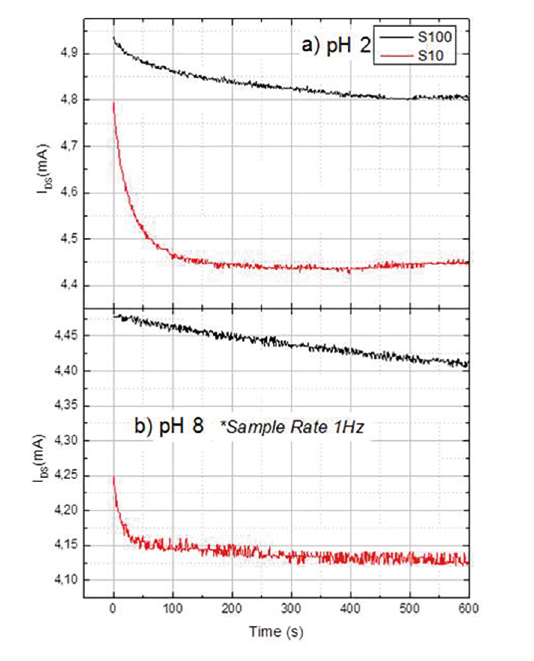
variation in time for samples S10 and S100 Figure 4. Current I DS when submerged into two different solutions: a) Acid solution (pH 2); b) Alkaline solutions (pH 8).